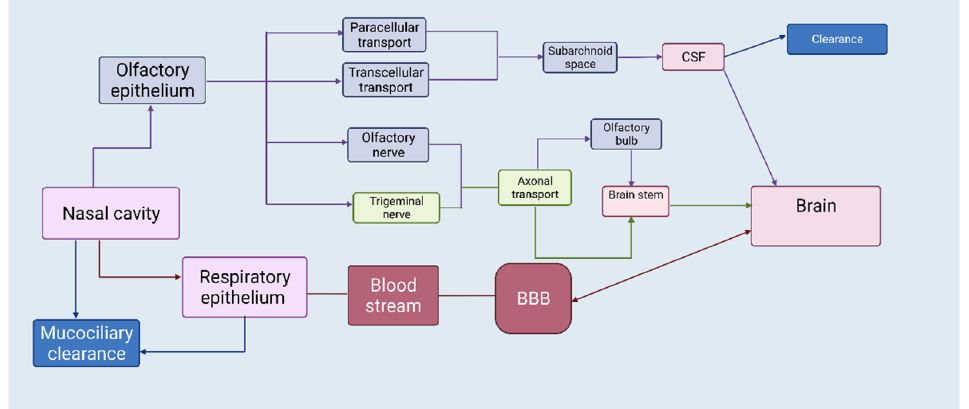
Figure 2. Nose-to-brain drug-transport pathways. After nasal administration drug molecules can reach the brain via olfactory, systemic, and trigeminal pathways. Olfactory and trigeminal pathways avoid first-pass metabolism of drugs and bypass BBB to deliver molecules directly to the brain via transcellular and paracellular transport. Created with BioRender.com (accessed on 25 June 2022).